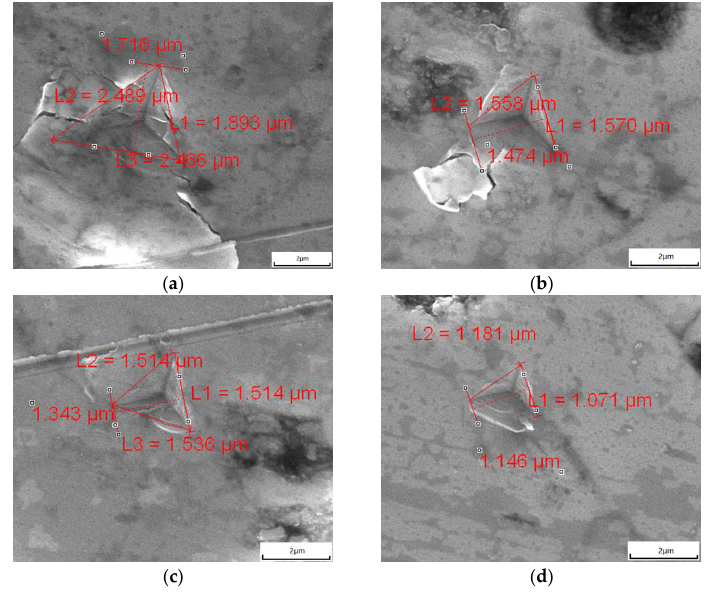
Figure 8. Indentations of the sintered 8YSZ bulk ( a ); GYYZO bulk with 5 wt% Gd 2 O 3 ( b ); 10 wt% Gd 2 O 3 ( c ) and 15 wt% Gd 2 O 3 ( d ). Table 6. Fracture toughness of the sintered bulks/MPa·m 0.5 . Bulks